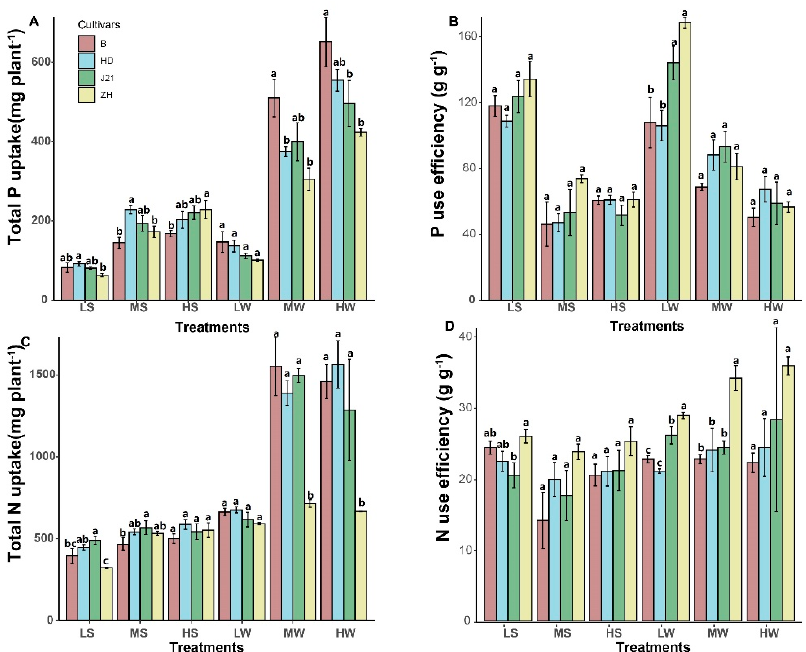
Figure 3. Total P uptake during whole growth period ( A ), P use efficiency for grain yield ( B ), total N uptake during whole growth period ( C ), N use efficiency for grain yield ( D ) of four soybean genotypes [B (Bailudou), HD (Huangsedadou), J21 (Jindou 21), and ZH (Zhonghuang)] under two water treatments [S (cycle water stress), W (well-watered)] and three P levels [L, low P supply (P0), M, mid P supply (P60), H, high P supply (P120)]. The letters under each group of bars indicate different combinations of P and water treatments (as per Figure 1). Values are means plus one standard error of the mean ( n = 3).